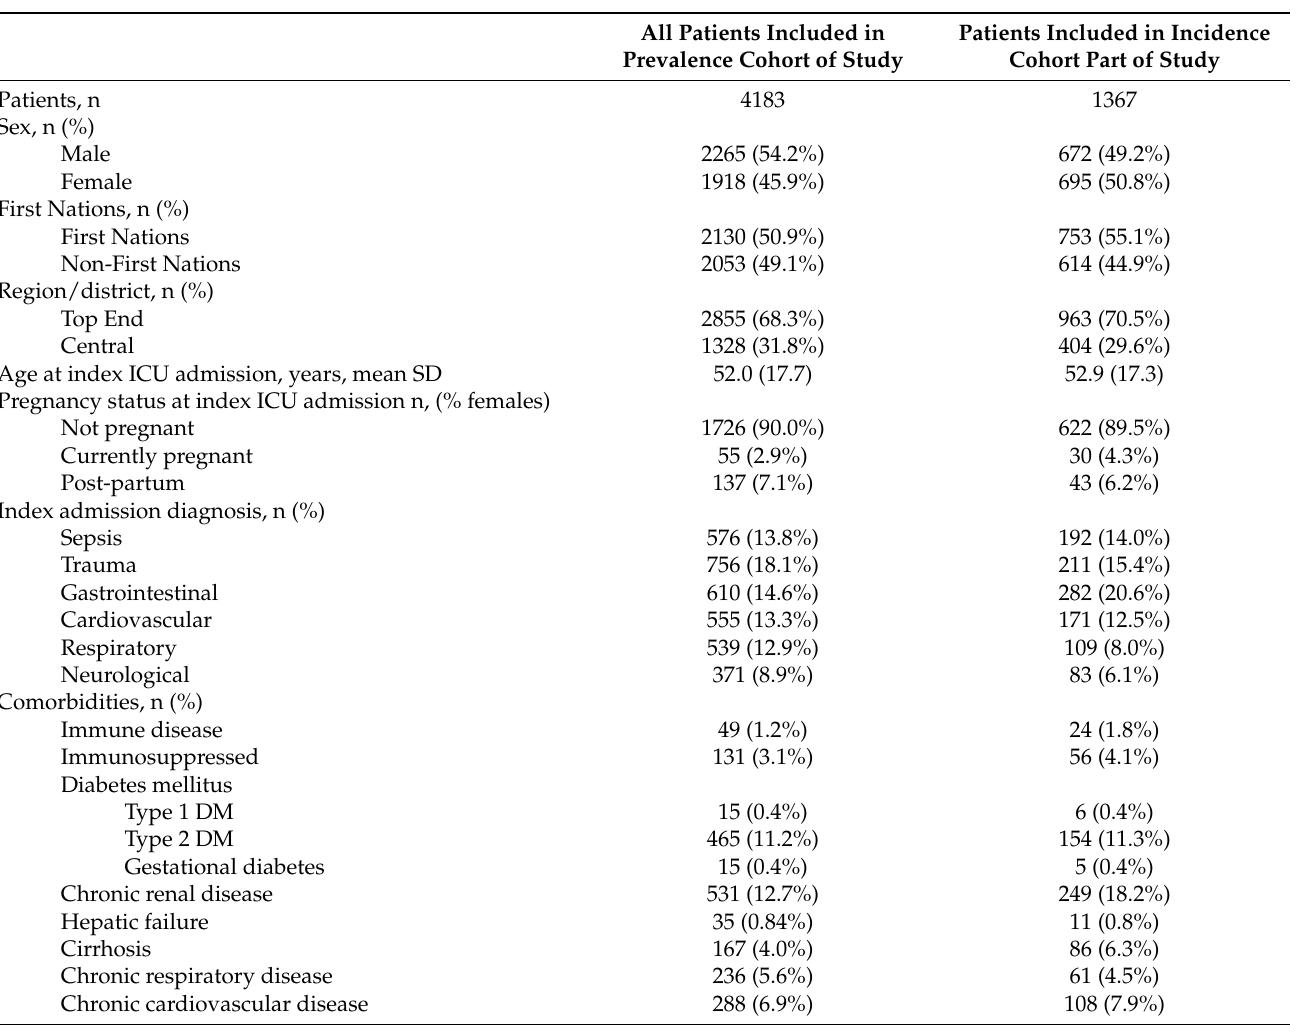
Table 2. Baseline characteristics at time of index ICU admission for all patients admitted to ICU with at least one RC antibody screen performed over the study period (2015–2019).